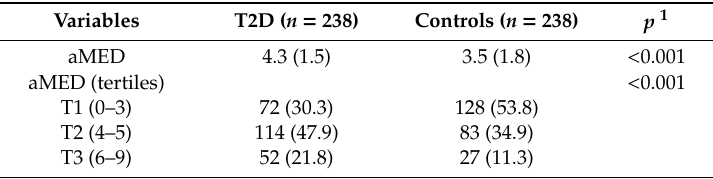
Table 2. Dietary quality index of the study